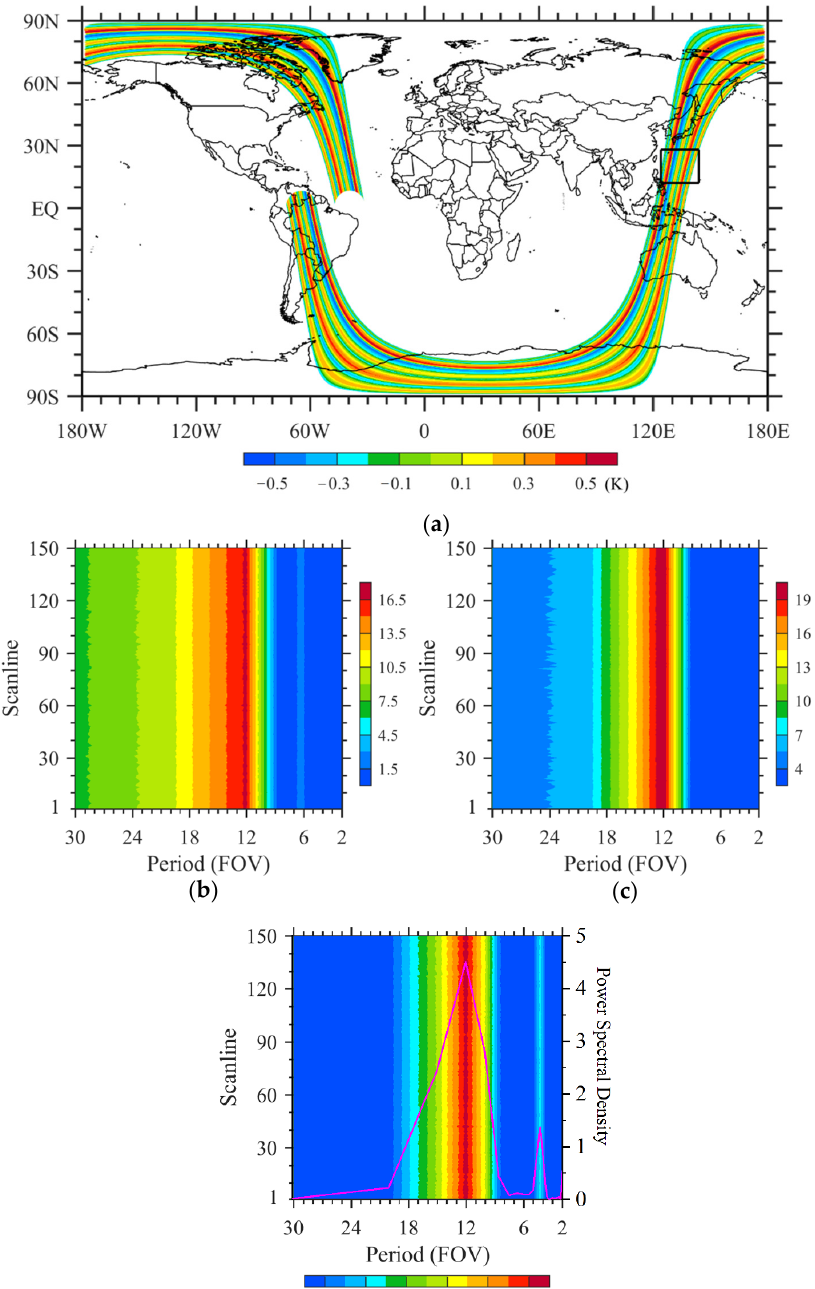
Figure 11. The along-track striping noise in TB observations at channel 1 over the same swath as Figure 3a. ( b , d ) Power spectral density for data noise in channels ( b ) 2, ( c ) 3 and ( d ) 4 along all scanlines indicated by a black box in ( a ). The power spectral density at the 30th scanline in ( d ) is also indicated by a magenta curve.